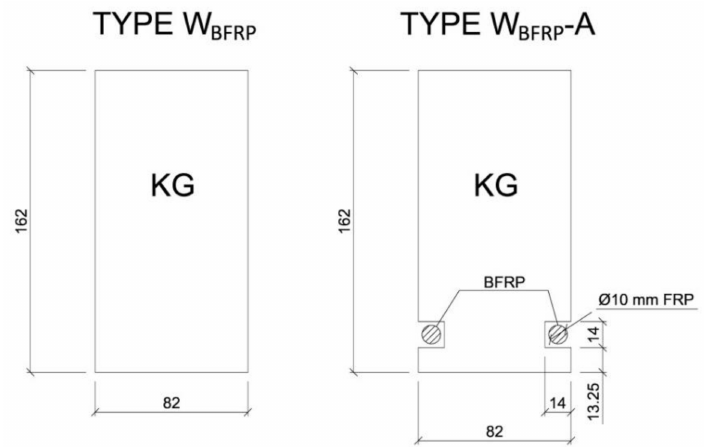
Figure 1. Cross-sections of the tested beams, type “W BFRP ” (dimensions in